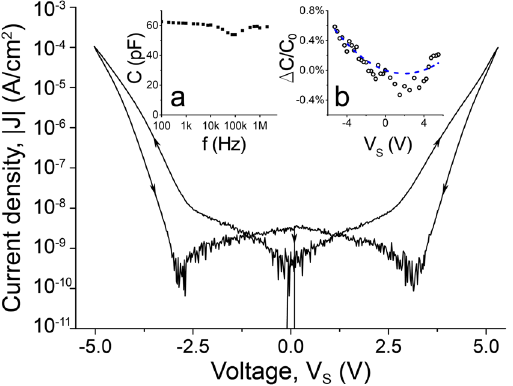
Figure 3. The dependence of the absolute value of the leakage current density, |J|, on the sample voltage, V S , for the nanocapacitor with 9 nm Al 2 O 3 layer. Black arrows indicate the sections of the dependence corresponding to forward and backward voltage ramp. Each half cycle lasts 1800 s. Inset ( a ) is the dependence of the capacitance on the frequency of the voltage signal with the amplitude equal 1 V. Inset ( b ) shows the dependence of the normalized capacitance Δ C/C 0 = (C − C 0 )/C 0 on the applied constant bias voltage (black circles). To exclude the hysteresis from the analysis, we use data points obtained during the voltage sweep from + 5 V to − 5 V. Blue dashed line corresponds to the parabolic fit of the data.